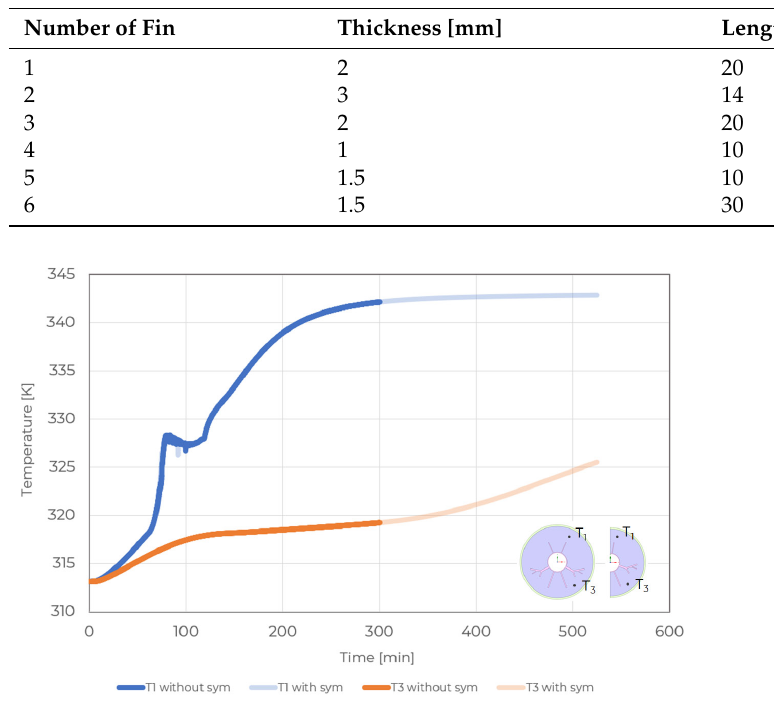
Figure 1. ( a ) Dimension and the cross-section of the LHTES unit, ( b ) Schematic description of the computational domain with input parameters. Table 1. Dimensions of the individual fins.